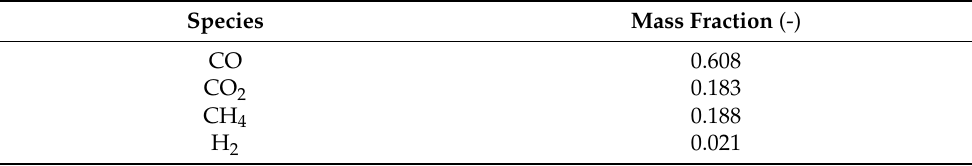
Table 1. Volatile composition of wood biomass.